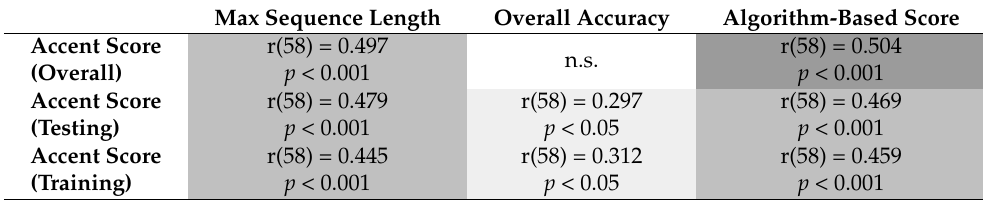
Table 1. Significant correlations between variables associated with phonetic and phonological learning (arranged vertically) and variables associated with auditory sensory memory (arranged horizontally) when all participants were considered together. Gray shading indicates the strength of the correlation (light gray = weak correlation, medium gray = moderate correlation, dark gray = strong correlation); n.s. = not significant.